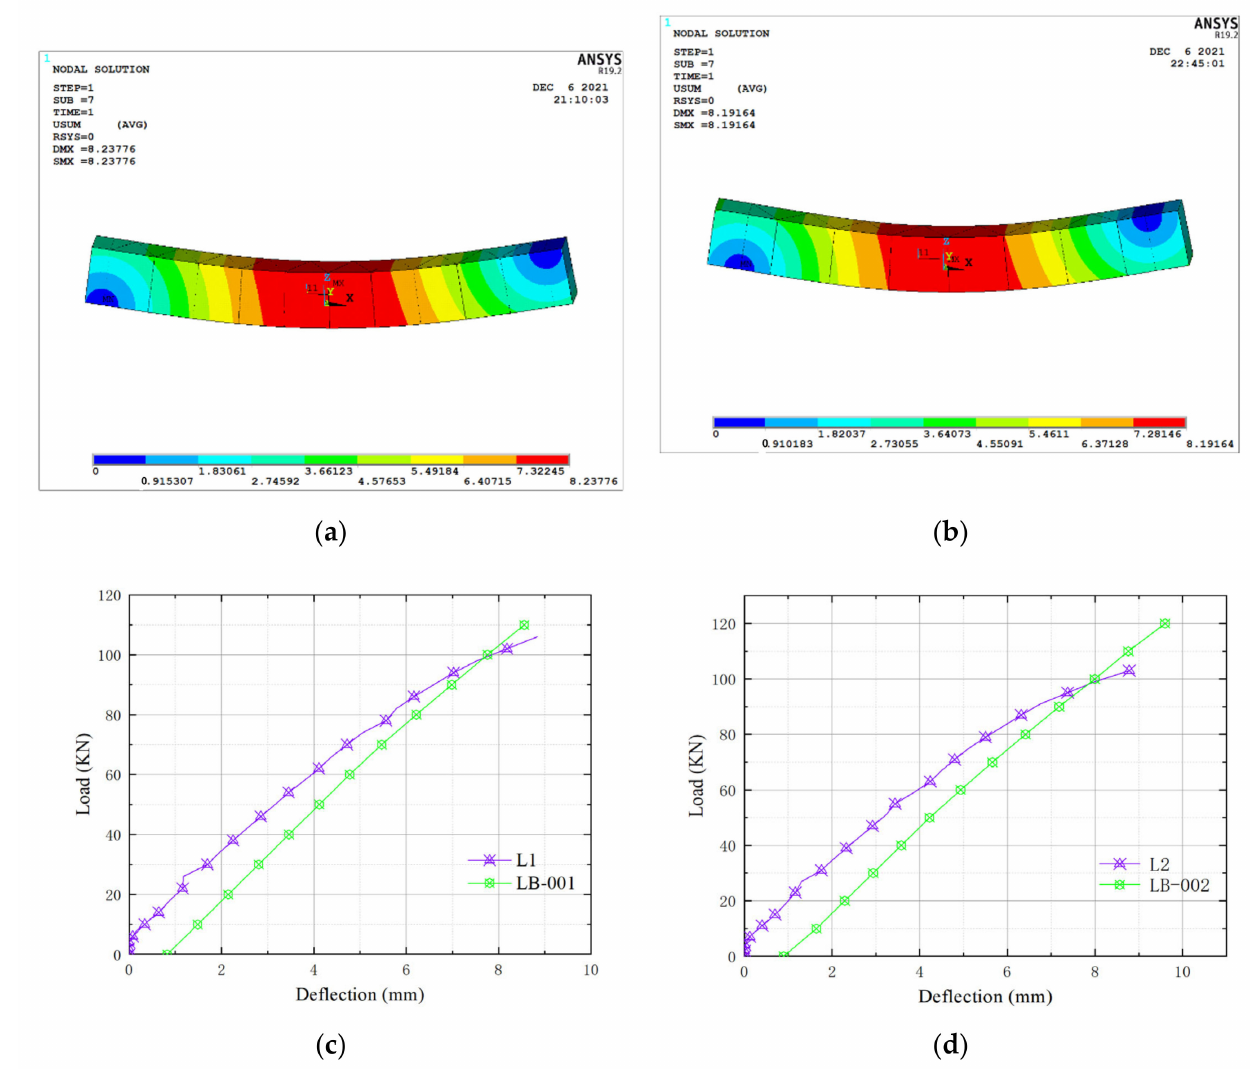
Figure 12. Comparison between software simulation results and test results: ( a ) Deflection cloud diagram of LB-001; ( b ) Deflection cloud diagram of LB-002; ( c ) Load-deflection comparison chart between L1 and LB-001; ( d ) Load-deflection comparison between of L2 and